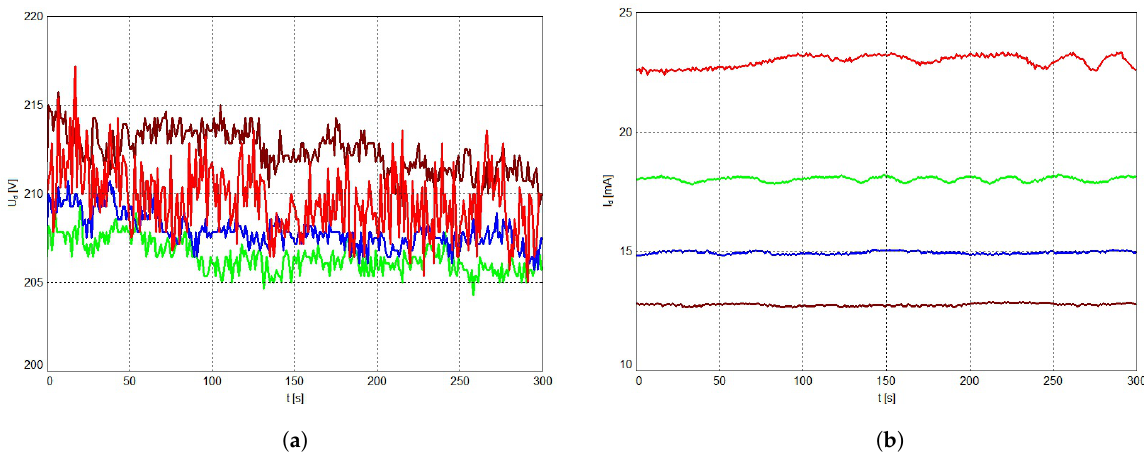
Figure 5. Time variation of the discharge voltage U d ( a ) and discharge current I d ( b ) for ballast resistance R b 2 equal to 10 k Ω (red), 20 k Ω (green), 30 k Ω (blue) and 40 k Ω (brown).